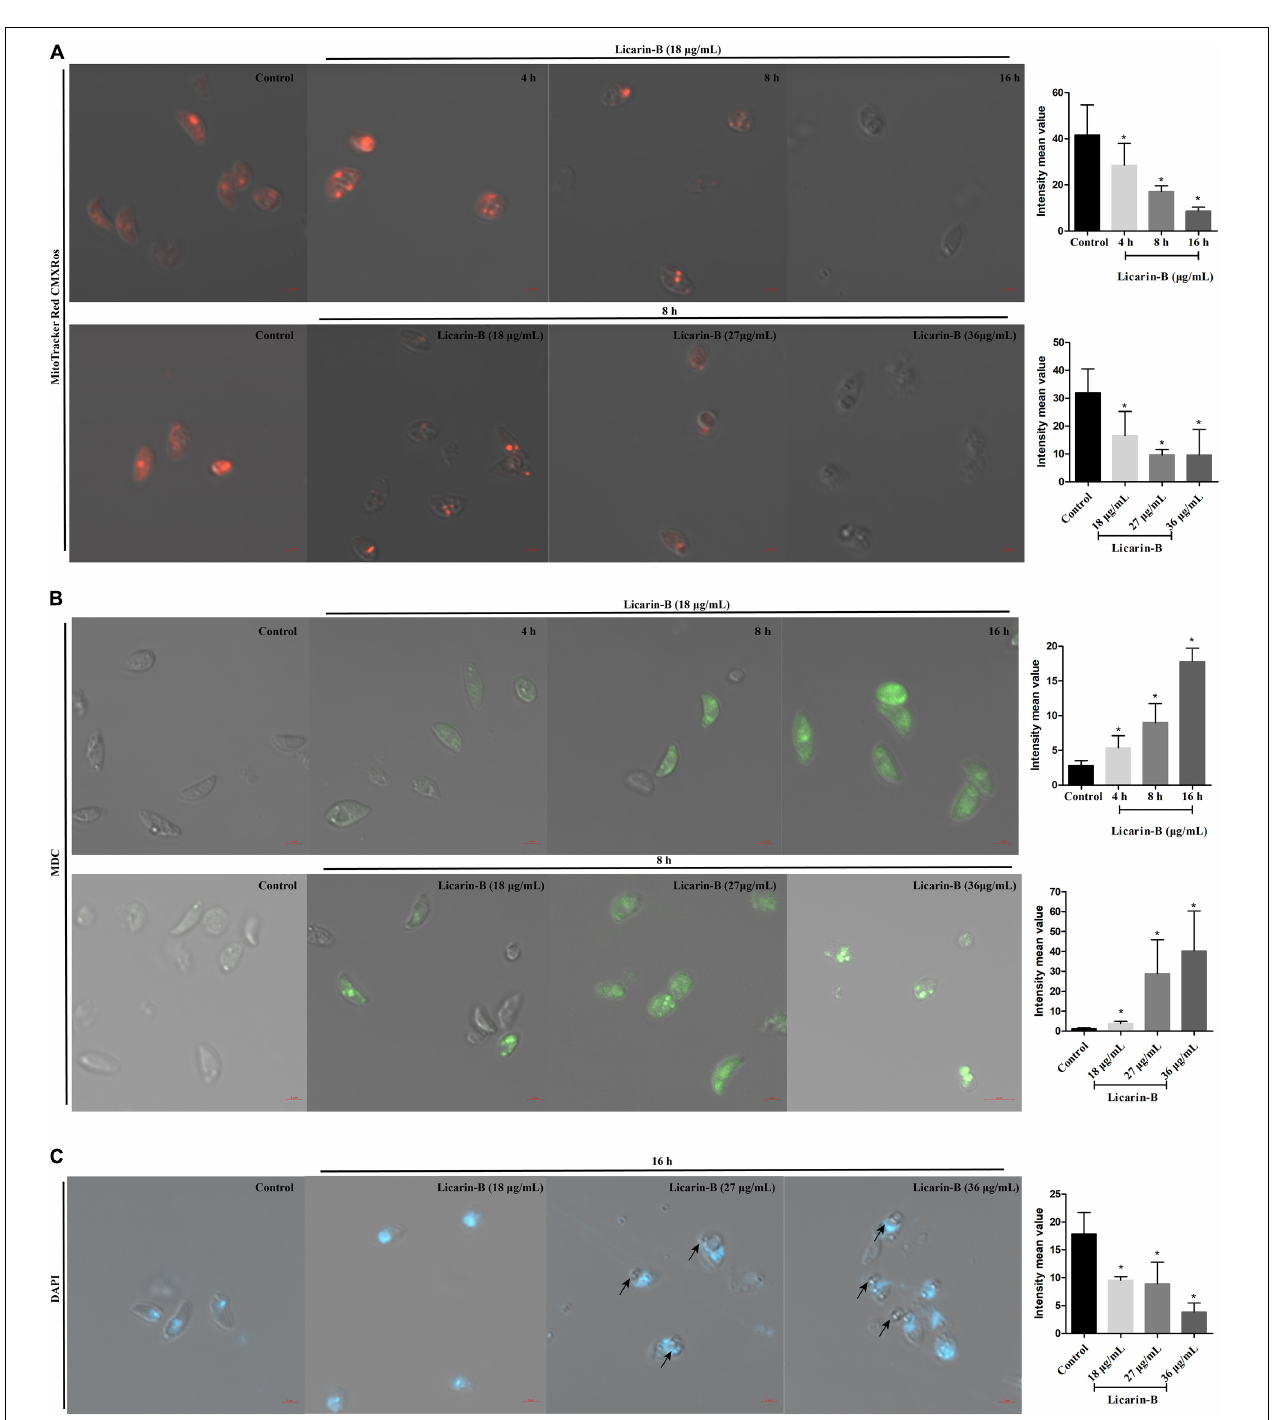
FIGURE 6 | Licarin-B induced mitochondrial damage in T. gondii (A) . T. gondii were incubated with licarin-B (18 µ g/mL) for 4, 8, or 16 h and with licarin-B (18, 27, or 36 µ g/mL) for 8 h or without any drug (as a control). Then, all the samples were stained with the MitoTracker Red CMXRos and observed by laser confocal microscopy. Licarin-B induced autophagy formation in T. gondii (B) . Tachyzoites were treated with licarin-B (18 µ g/mL) for 4, 8, or 16 h; with licarin-B (18, 27, or 36 µ g/mL) for 8 h at 37 ◦ C; or with no drug (as a control). They were then stained with MDC working solution (100 µ M), and visualized by laser scanning confocal microscopy. Licarin-B induced nuclear disintegration (C) . T. gondii were treated with licarin-B (18, 27, or 36 µ g/mL) or without drug as a control for 16 h and stained with DAPI; the fluorescence intensity was observed by laser confocal microscopy. Scale bars: 2 µ m. The intensity mean value of MitoTracker Red CMXRos, MDC, or DAPI staining were calculated. * p < 0.01 compared with the parasite control.